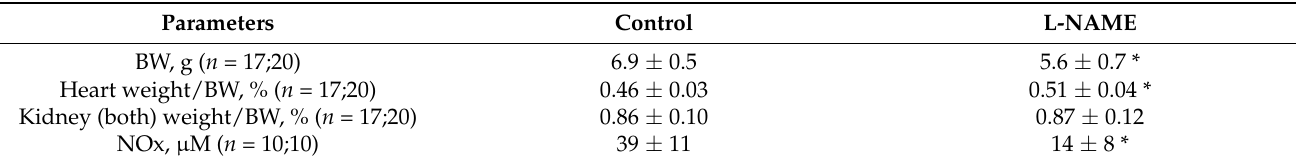
Table 1. Bodyweight (BW), organ weights as well as concentrations of NO metabolites in serum of 1-day-old rat pups from control and L-NAME groups.